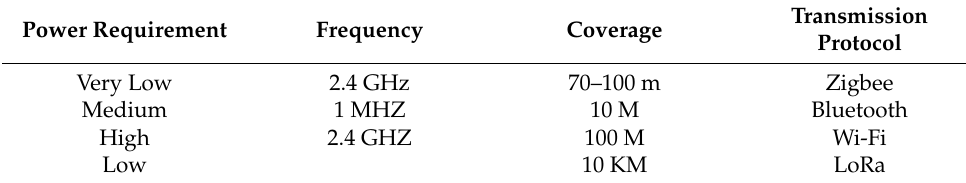
Table 2. Transmission protocols.